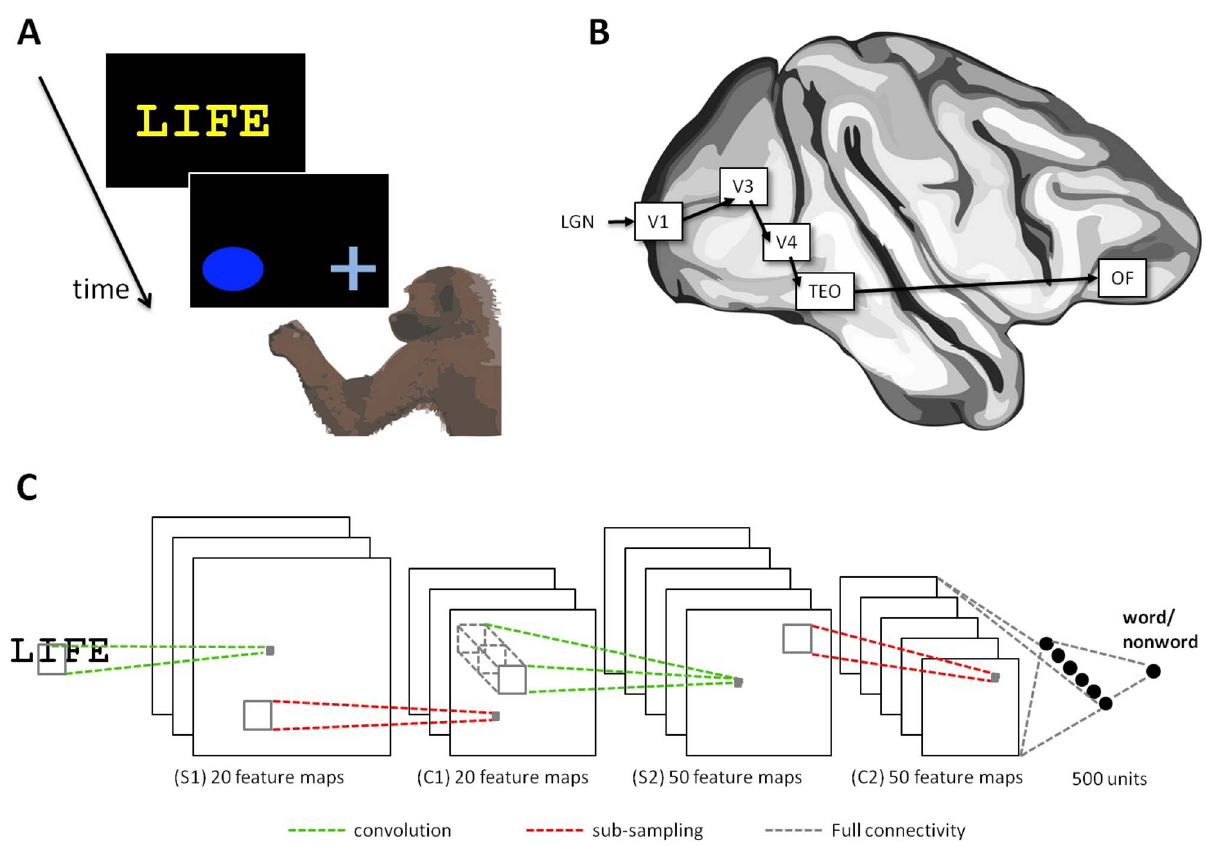
Figure 1. (A) Word-Nonword classification by operant conditioning in baboons [ 1 ] . Six baboons were trained to distinguish English words (such as ‘‘LIFE’’) from nonwords (such as ‘‘LEFE’’), by touching either the cross or the oval shape presented immediately after the word or nonword. A correct response was followed by a blank screen and a food reward, whereas an incorrect response prompted a green screen to appear for 3s. (B) Main cortical network presumed to be involved in distinguishing between words and nonwords, formed by a succession of increasingly selective regions throughout the ventral stream (LGN-V1-V3-V4-TEO) towards the orbito-frontal cortex (OF). (C) Deep learning convolutional network implementing the local and hierarchical connectivity found in the ventral pathway, through a succession of alternating simple convolution and complex pooling levels (cortical regions not mapped to network levels).